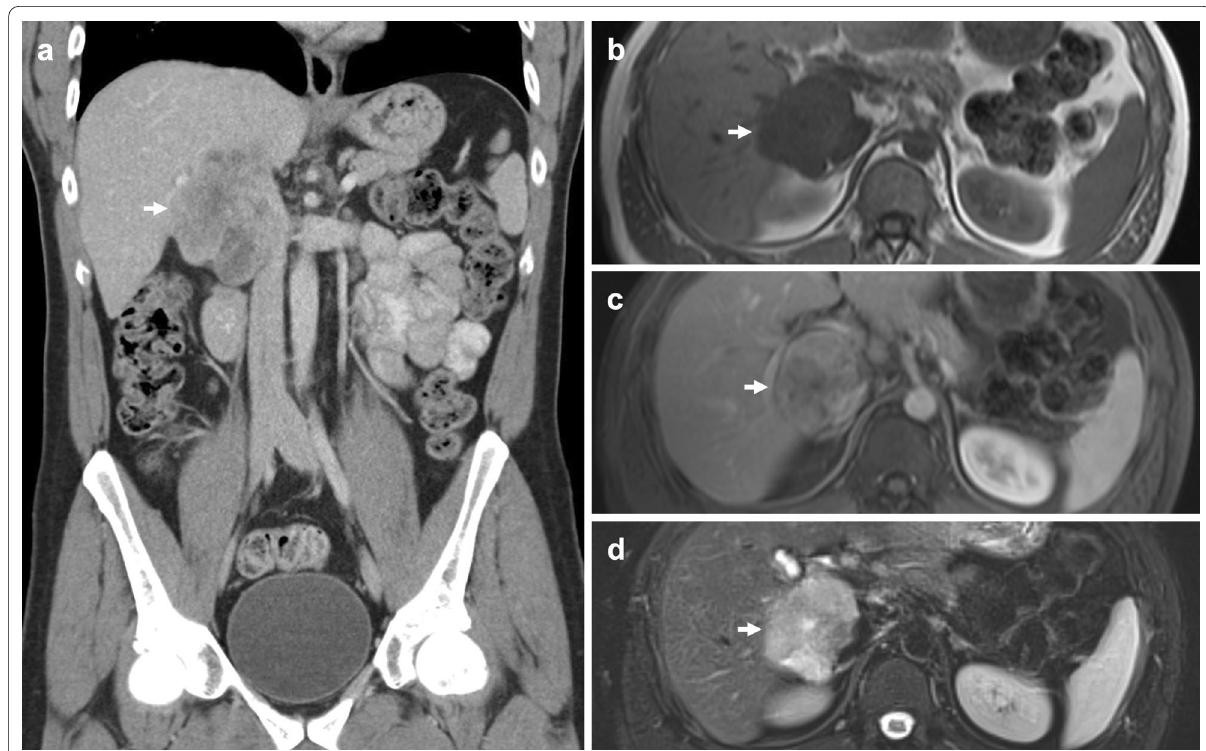
Fig. 14 IVC Leiomyosarcoma. a Coronal CT image shows a large lobulated heterogeneously enhancing mass (arrow) between the liver and right kidney. It demonstrates both intra and extraluminal growth. On axial MRI, the lesion (arrows) is ( b ) homogeneously T1 hypointense to skeletal muscle, ( c ) enhances heterogeneously, and ( d ) is heterogeneously T2 hyperintense. Some non-enhancing areas are bright on T2 weighted sequences, suggestive of cystic or necrotic components. MRI also demonstrates a positive embedded organ